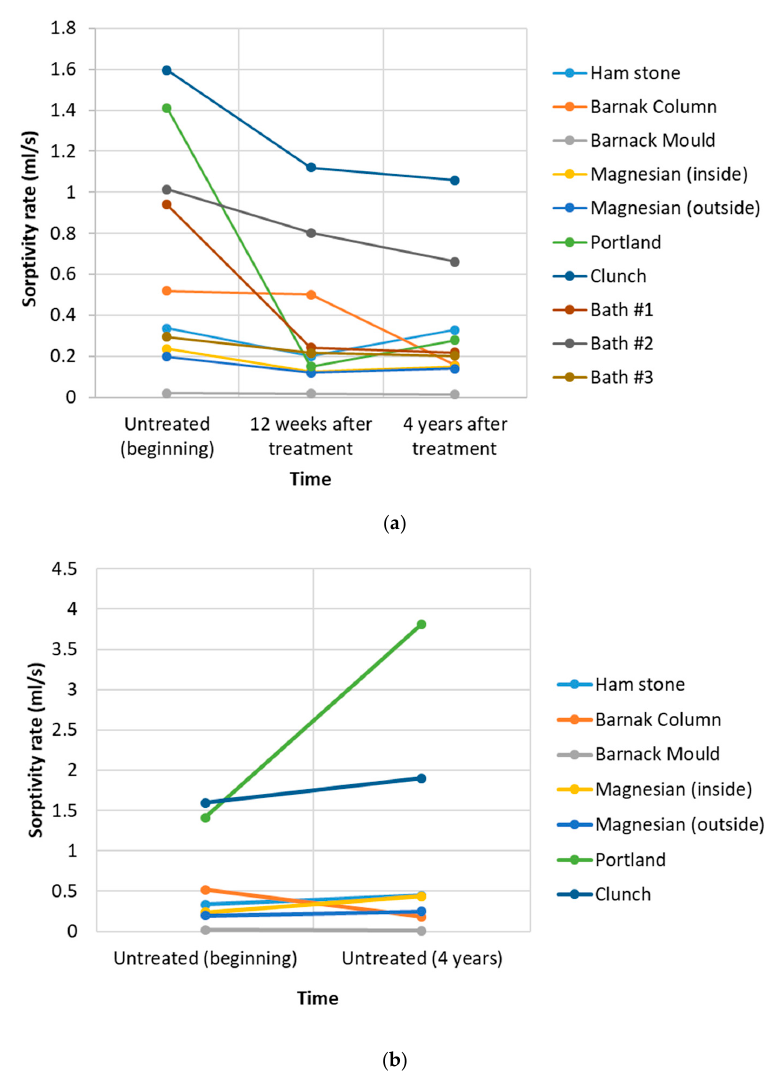
Figure 8. ( a ) Sorptivity rates of the various stone specimens untreated (beginning) and after 12 weeks and 4 years. ( b ) Comparison of the sorptivity rate of the untreated stone at the beginning and the end of the testing period (4